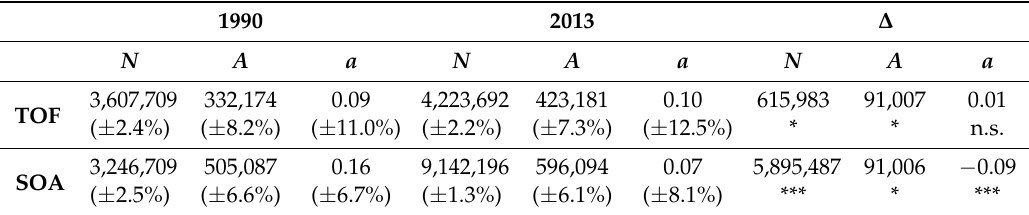
Table 1. Number ( N ), coverage ( A , in ha) and average size ( a , in ha) of small patches (SOA and TOF) at 1990 and 2013 ( ± their estimated relative standard errors, in percentage). Significance levels (not significant for p value > 0.1, significant for p value ≤ 0.1, very significant for p value ≤ 0.05 and extremely significant for p value ≤ 0.01) of changes between 1990 and 2013 ( ∆ ) are also reported in the summary tables with the relative symbol (n.s., *, **, ***,